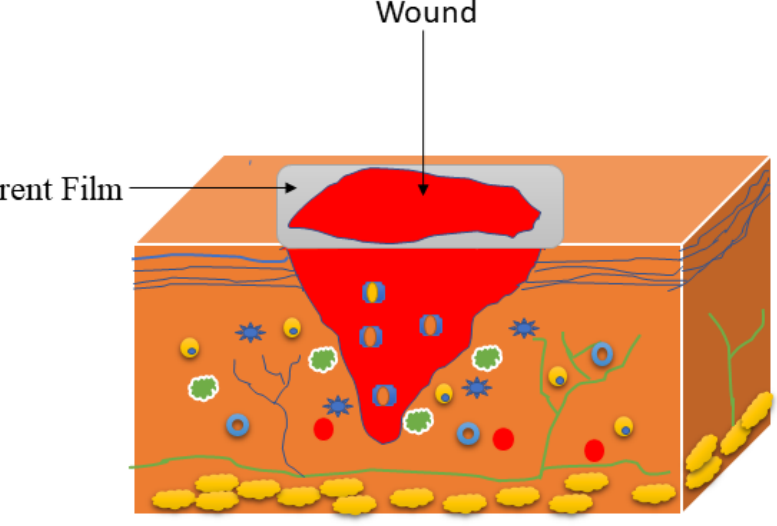
Figure 4. Film-based wound dressing